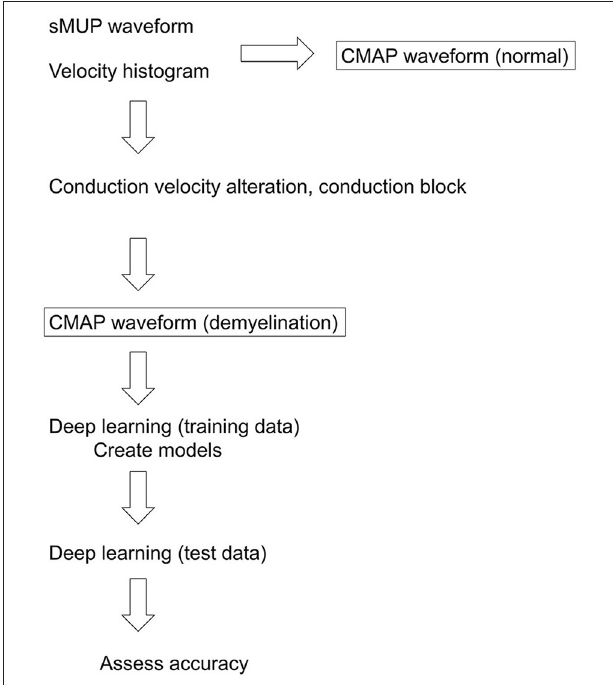
FIGURE 2 | Overall flow of the study. sMUP, single motor unit potential; CMAP, compound muscle action potential.